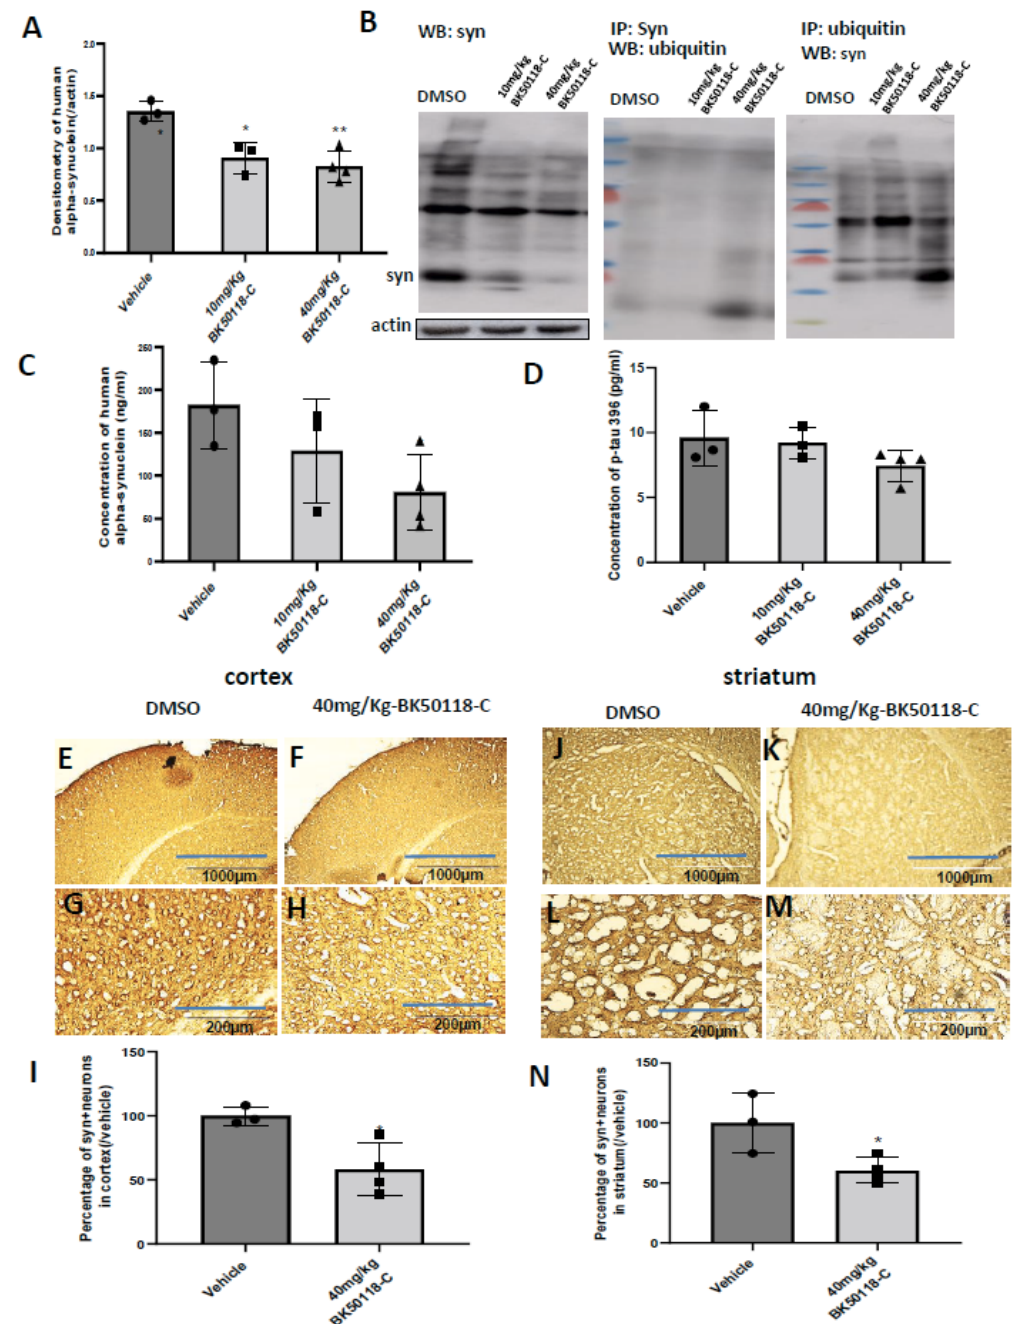
Figure 4. BK50118-C significantly reduced alpha-synuclein but not p-tau levels in TgA53T mice. Male and female TgA53T mice were treated with intraperitoneal injection of vehicle or BK50118-C at the daily dosage of 10 mg/Kg or 40 mg/Kg for 7 days. WB of midbrain lysates showing ( A ) the levels of alpha-synuclein relative to actin on 4–12% SDS-NuPAGE gel in the above mice. ( B ) The first blot is the WB densitometry. The 2nd and 3rd blots are IP alpha-synuclein (syn) or ubiquitin. ELISA showing ( C ) the levels of alpha-synuclein and ( D ) ptau396 following BK50118-C treatment. Asterisks indicate statistic significant difference * p < 0.05 or ** p < 0.01 vs. corresponding vehicle. Ordinary one-way ANOVA was used for the analysis. N = 3–4 mice per group. DAB +Nissl staining. C significantly reduced alpha-synuclein levels in cortex ( F / H ) and striatum ( K / M ) compared to the corresponding vehicles ( E / G ) or ( J / L ) , verified by the quantification of alpha-synuclein positive cells in cortex ( I ) and striatum ( N ). Two-tailed student t test was used for analysis, and * indicates p < 0.05 vs. vehicle. N = 3–4 per group. All values presented as Mean ± SD. Scale bars: 100 µ m ( E , F , J , K ) or 200 µ m ( G , H , L , M